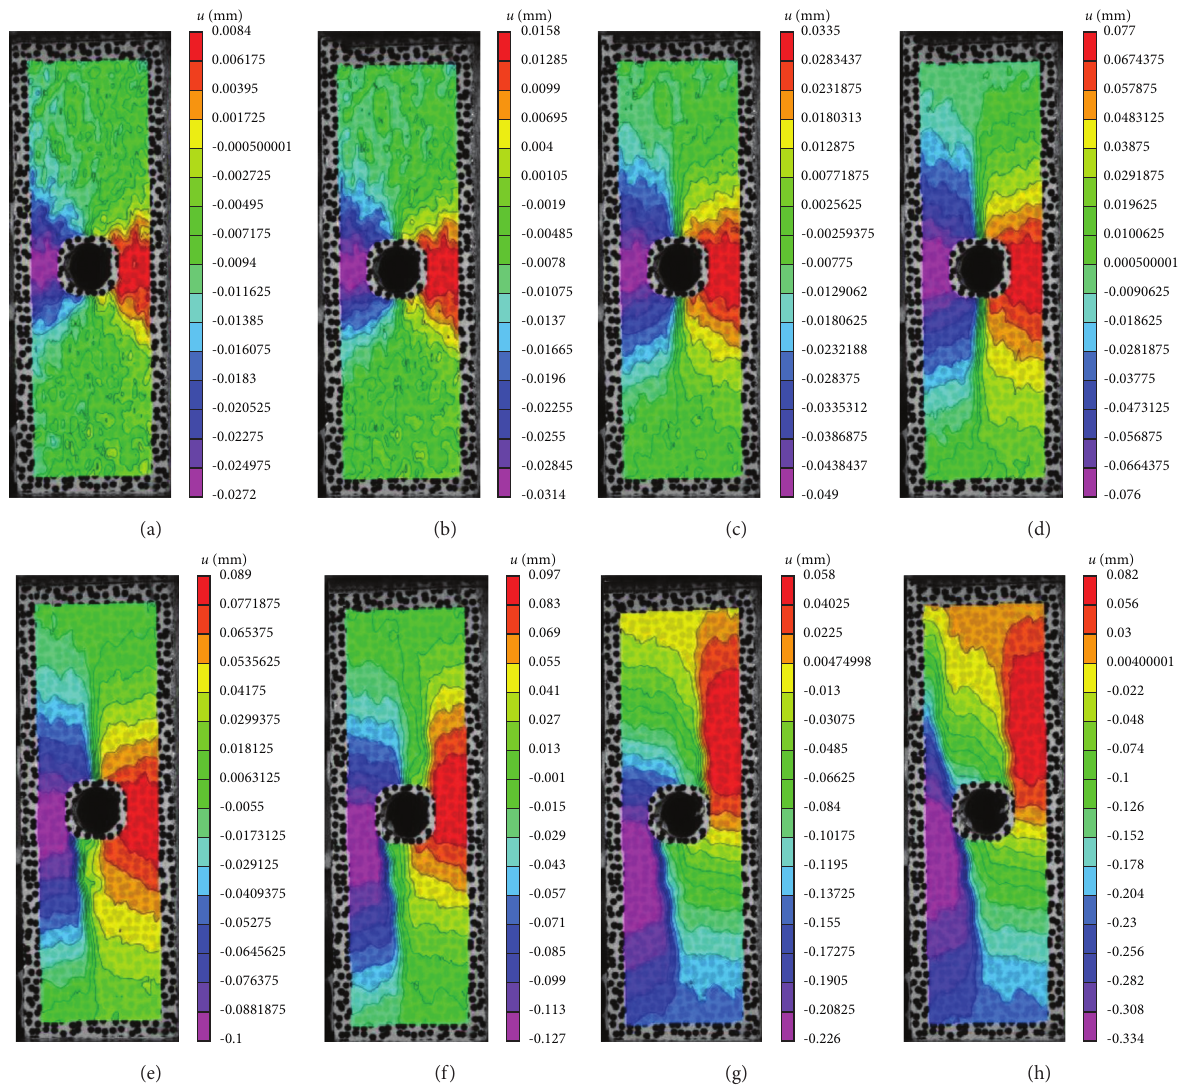
Figure 13: The nephogram of the horizontal displacement field at different stress levels corresponding to points A–H in Figure 12.